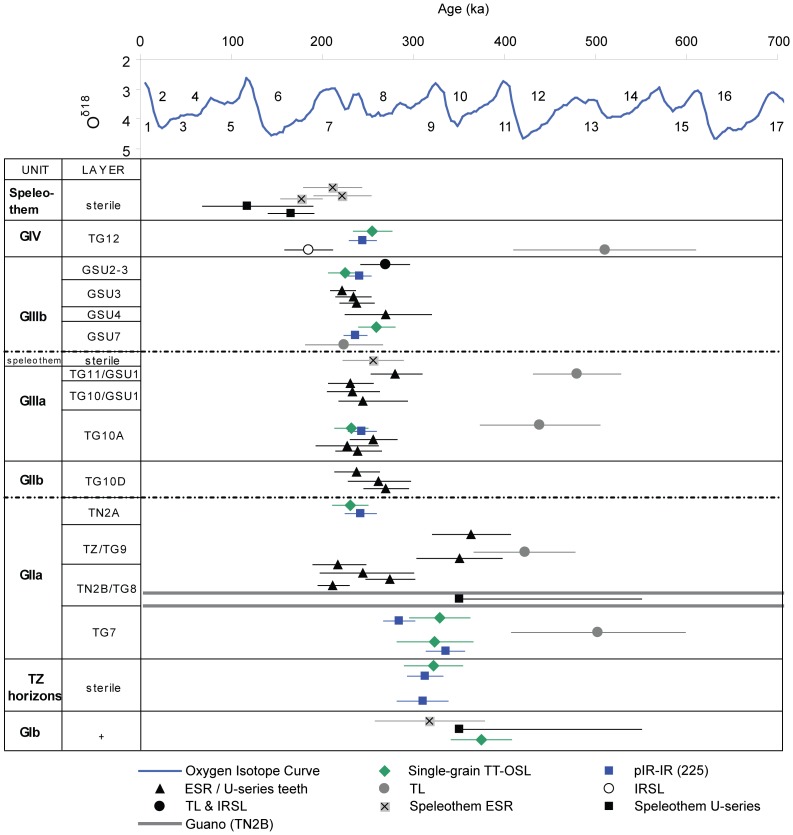
Published ages obtained using different dating methods (including this study) for the various allostratigraphic units and lithologic/archaeo-palaeontological levels at Galería.The data included here has been derived from combined ESR/U-series dating of teeth [15], TL and IRSL dating of sediment [14], ESR dating of calcite/speleothems [11], [104], U-series dating of calcite/speleothems [11], [15]. The numerical age estimates are shown against the Marine Oxygen Isotope curve record [94]. Two additional TL ages of 1340±170 ka (unit GIV) and 3000±1800 ka (unit GI) [14] are not shown on this plot as they lie beyond the x-axis limits (see Table 2 for a full summary of the dataset in [14]).